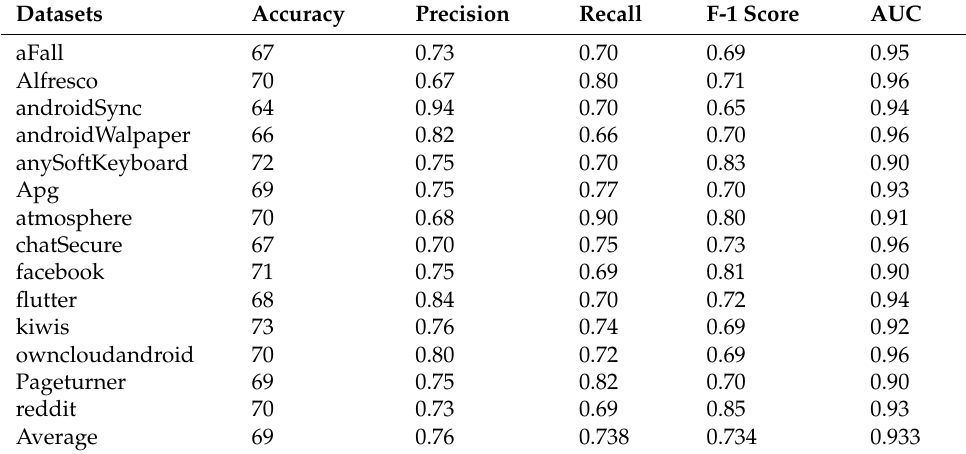
Table 3. CNN defect prediction results (within-project analysis).